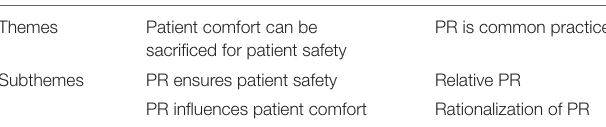
TABLE 2 | Summary of themes and subthemes.